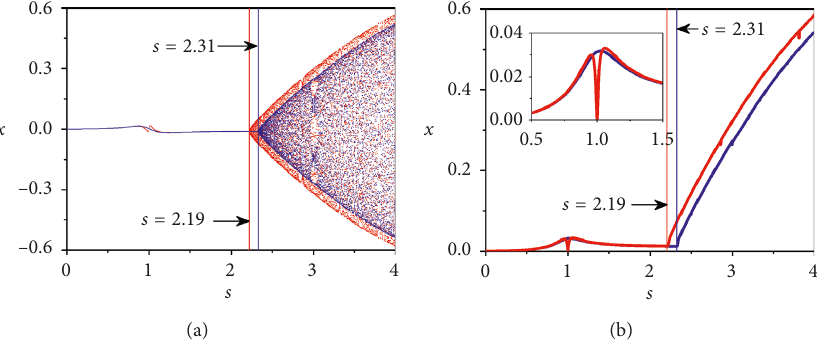
Figure 19: (a) The bifurcation diagram and (b) the amplitude-frequency response curve of the rotor/seal system attached with the DVA in the x -coordinate when ζ a 0 and σ a (cid:31) (cid:31)